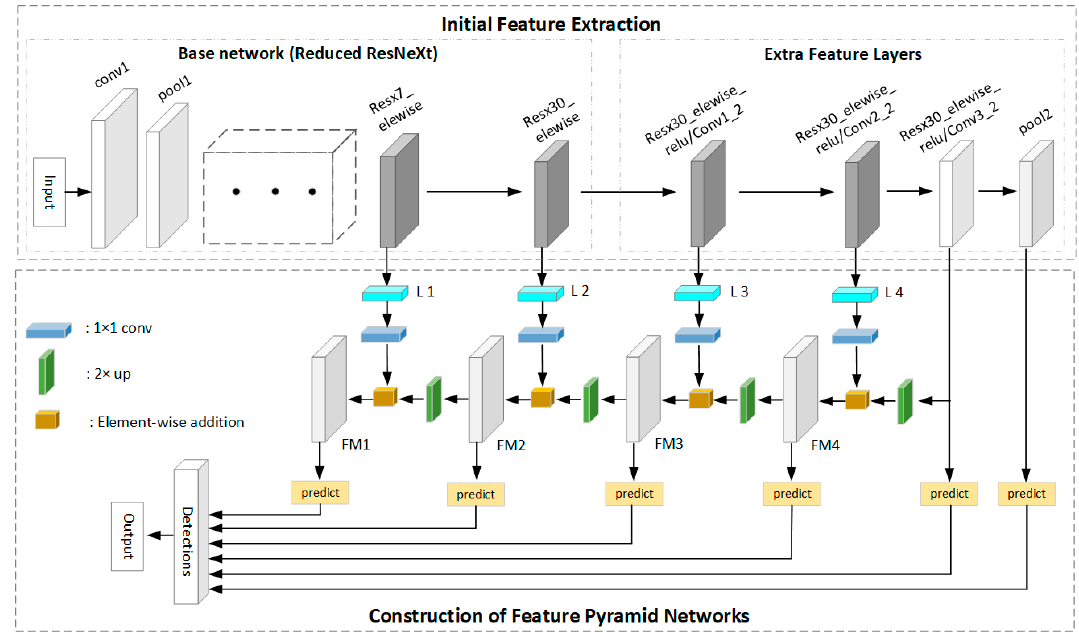
Figure 5. The framework of proposed SSFPD network.